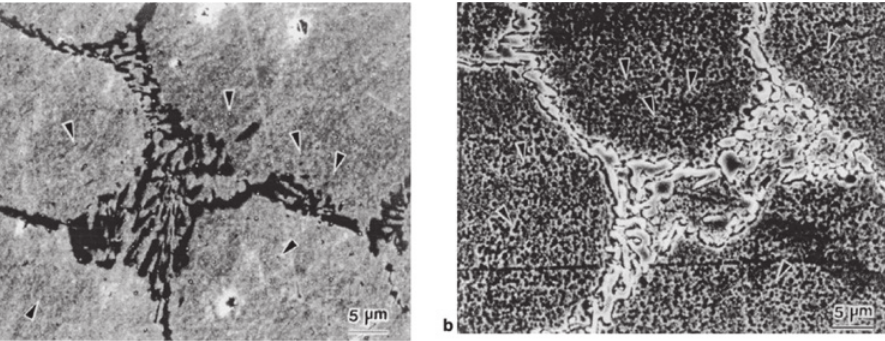
Fig. 11: Scanning electron microscopy (SEM) images illustrating porosity in unused tube: (a) as polished and (b) etched sample